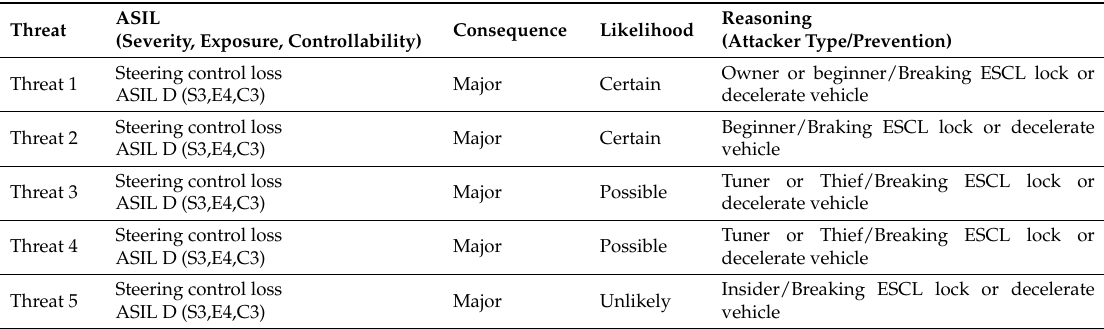
Table 14. Likelihood and Consequences Values for Automotive Threats.